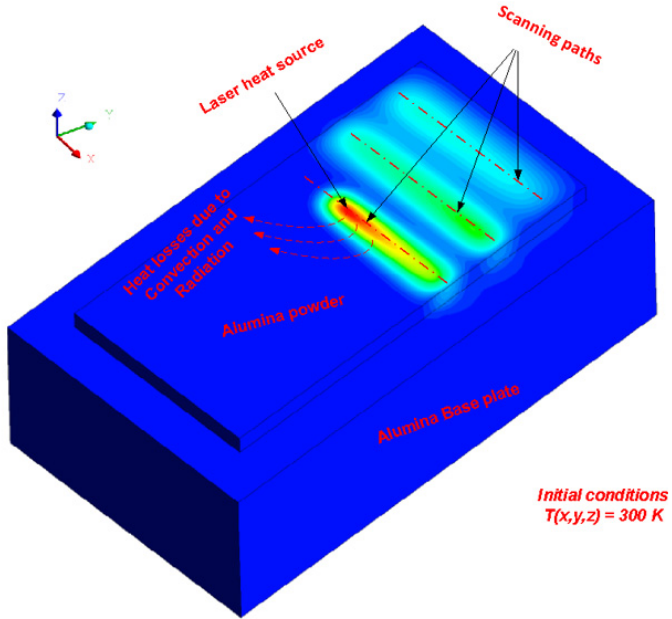
Figure 4. The boundary and initial conditions considered in the numerical modeling. Alumina material properties (the effect of colloidal graphite on the material properties was ignored since it is only 0.1 vol%) as a function of temperature (as described in Table 1) and other constants, according to [36], were considered in the developed numerical model and included in the developed UDF. Additionally, the UDF considered the phase transfor- mation from solid to liquid and liquid to solid based on the latent heat of melting. User Defined Memory (UDM) available in ANSYS FLUENT was used to monitor the molten region during the movement of the Table 1 . Physical and thermal properties of alumina feedstock. Property Value Ref.